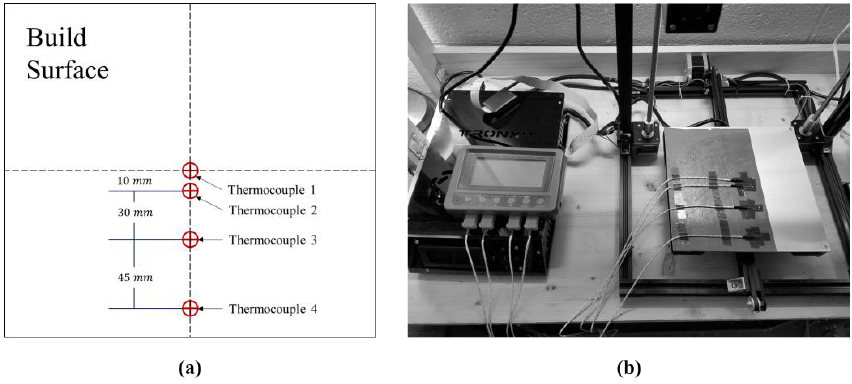
Figure 15. Heat loss experiment setup, where ( a ) shows the thermocouple arrangement and ( b ) shows the physical setup of the